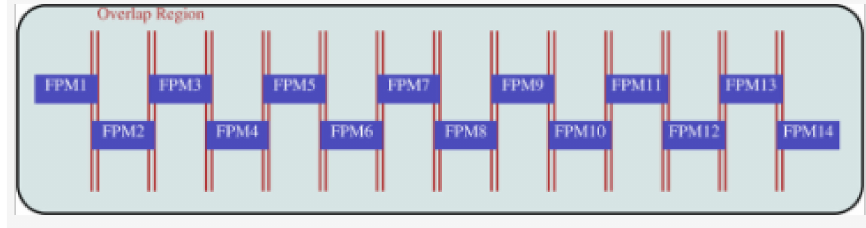
Figure 2. Focal plane modules layout of the Landsat 8 Operational Land